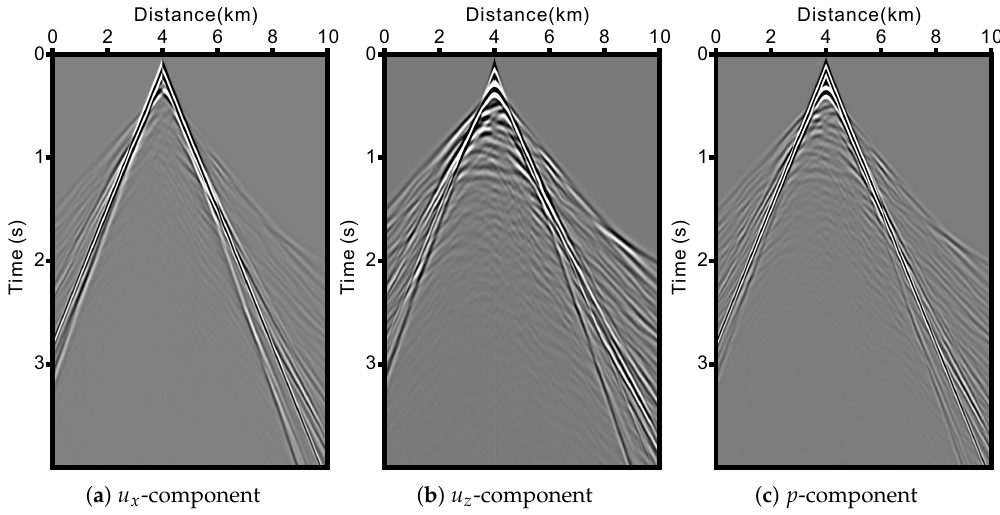
Figure 5. Observed multicomponent seismic data: ( a ) horizontal and ( b ) vertical displacement and ( c ) pressure